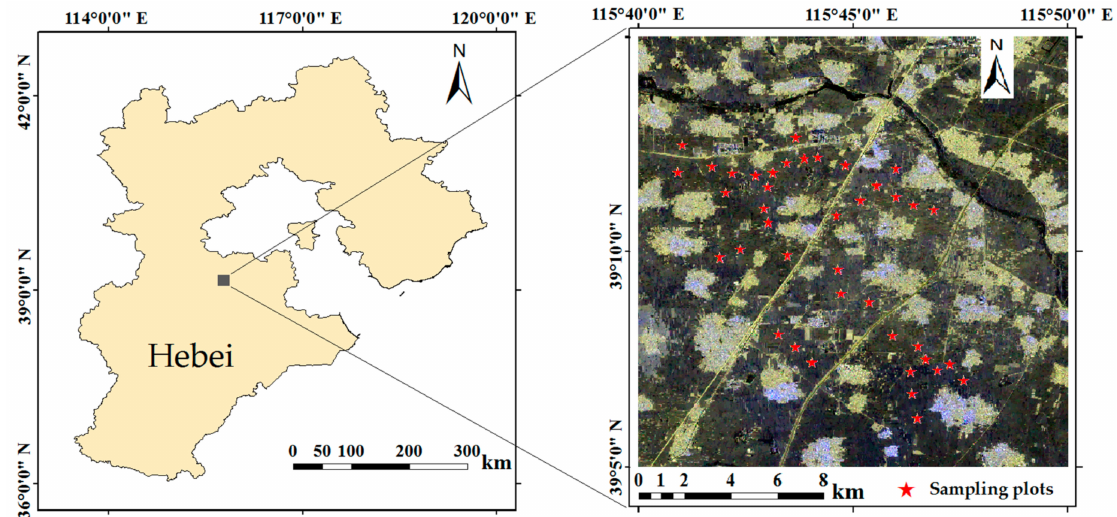
Figure 1. Location of the study region and the distribution of the sampling plots in the study site. The background image is a polarization composite image of RADARSAT-2 (R: VH, G: HV, B: HH) in the study